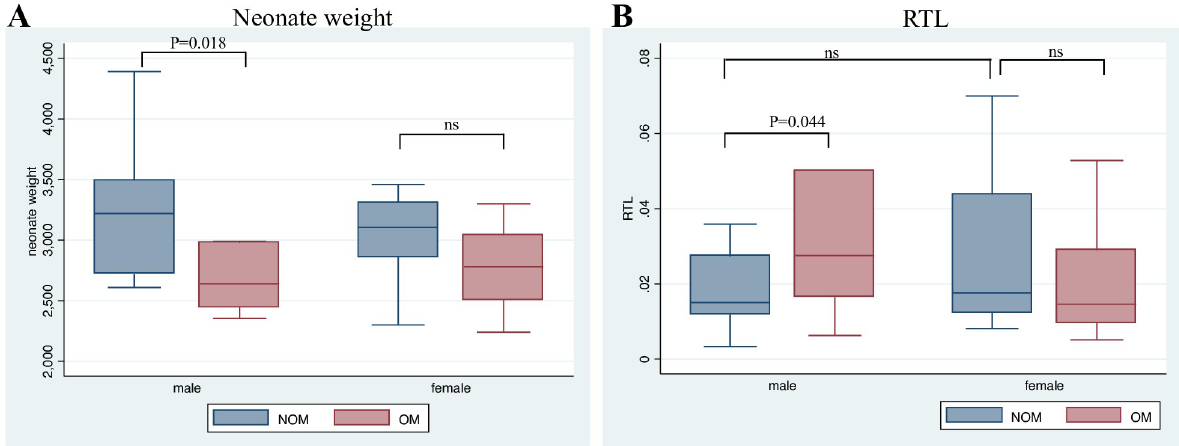
Fig 1. Neonate weight and relative telomere length (RTL) in OM and NOM offspring. Box plot diagram of neonate (A) weight, and (B) relative telomere length (RTL) in male and female offspring in OM and NOM groups. Box plot explanation: upper horizontal line of box, 75th percentile; lower horizontal line of box, 25th percentile; horizontal bar within box, median; upper horizontal bar outside box, maximum value except for outliers; lower horizontal bar outside box, minimum value except for outliers; p < 0.05 indicates statistical significance between groups based on Wilcoxon Rank Sum test. OM: opioid using mothers, NOM: Healthy controls (Not-opioid using mothers), ns: not significant.